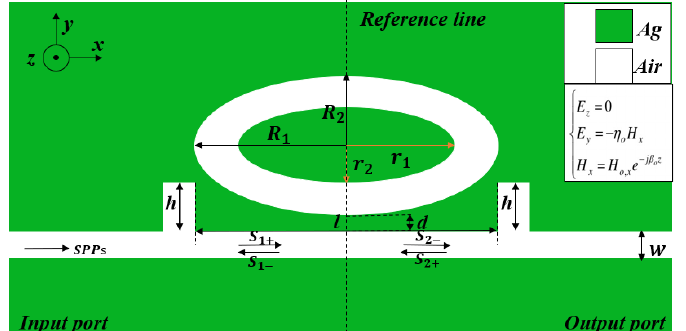
Figure 1. The 2D schematic of the structure composed of a metal – insulator – metal (MIM) with two symmetric rectangular stubs coupled with the elliptical ring resonant cavity. The expression of the incident electric and magnetic field is shown in the upper right corner of the picture.